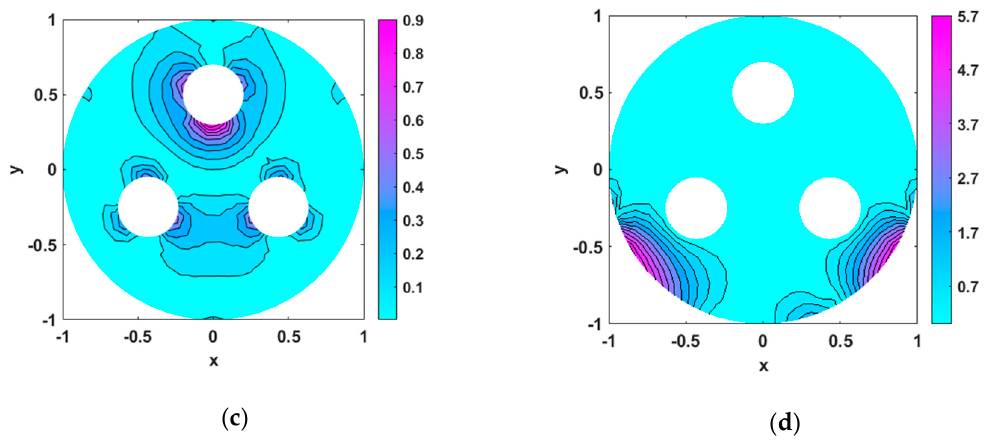
Figure 16. Contour plots of absolute errors (%): ( a ) unknown upper inner boundary; ( b ) three half unknown inner boundaries; ( c ) unknown inner boundaries; ( d ) half unknown outer boundary.